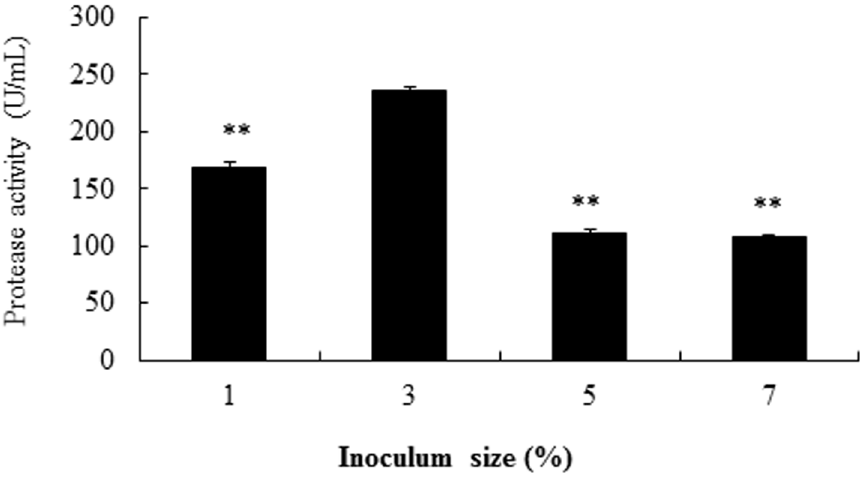
Fig 9. Effects of inoculum size in influencing the production of alkaline protease from strain SD8. The single factor investigated was selected at optimal conditions. ** P < 0.01 compared to 3% inoculum size. All the data were given as means ± SEM (n =